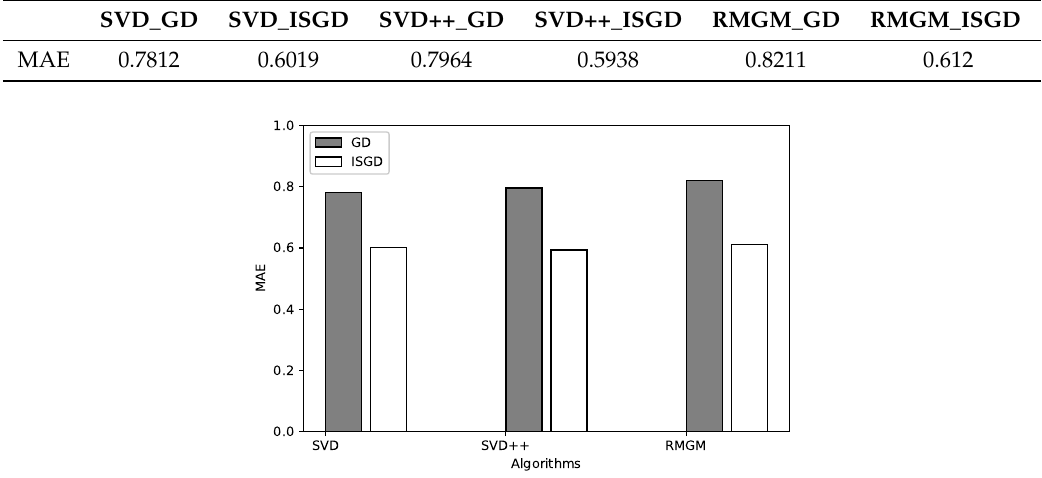
Table 4. Comparison of MAE with other techniques.